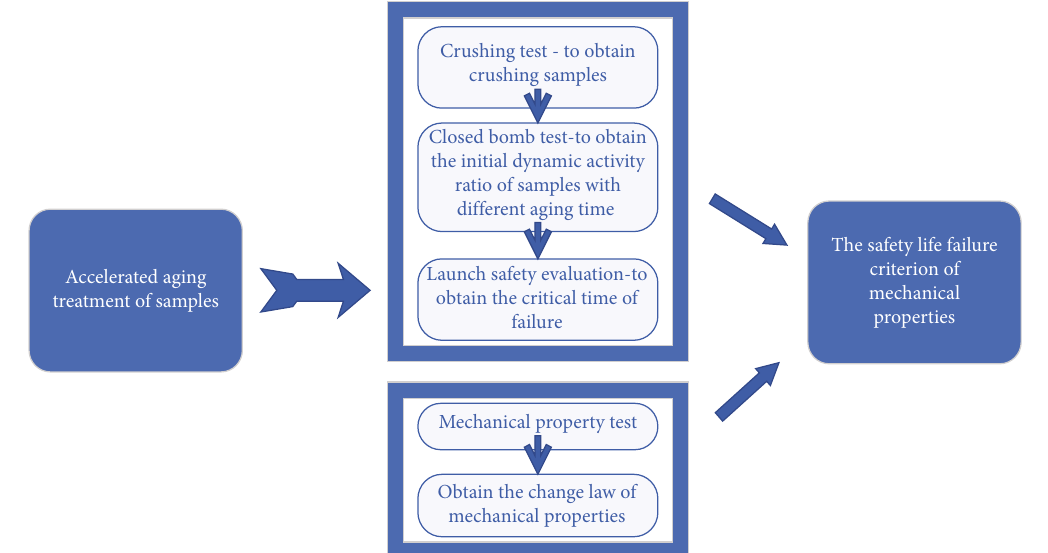
Figure 1: Flowchart of the experimental